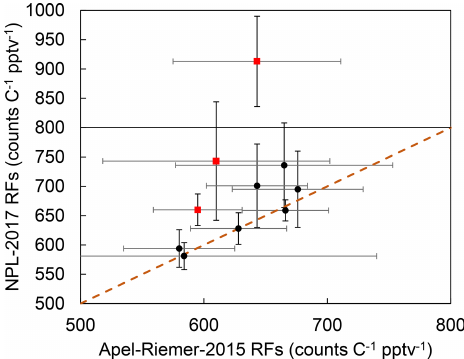
Figure 3. Response factor comparison between the 10 common compounds measured from both Apel-Riemer-2015 and NPL-2017 gas calibration standards. The black circles show the average of all the calibration-level data points for the corresponding compounds measured with the Apel-Riemer-2015 and NPL-2017 gas calibra- tion standards. The x - and y -axis whiskers represent the standard deviation of all the measured data points for the corresponding compound with the Apel-Riemer-2015 and NPL-2017 standards, respectively. The brown dashed line shows the one-to-one RF corre- lation between the two measurement experiments. The red squares with black whiskers show the pentane, ethylbenzene, and toluene 1 σ outliers (from the bottom of the graph to the